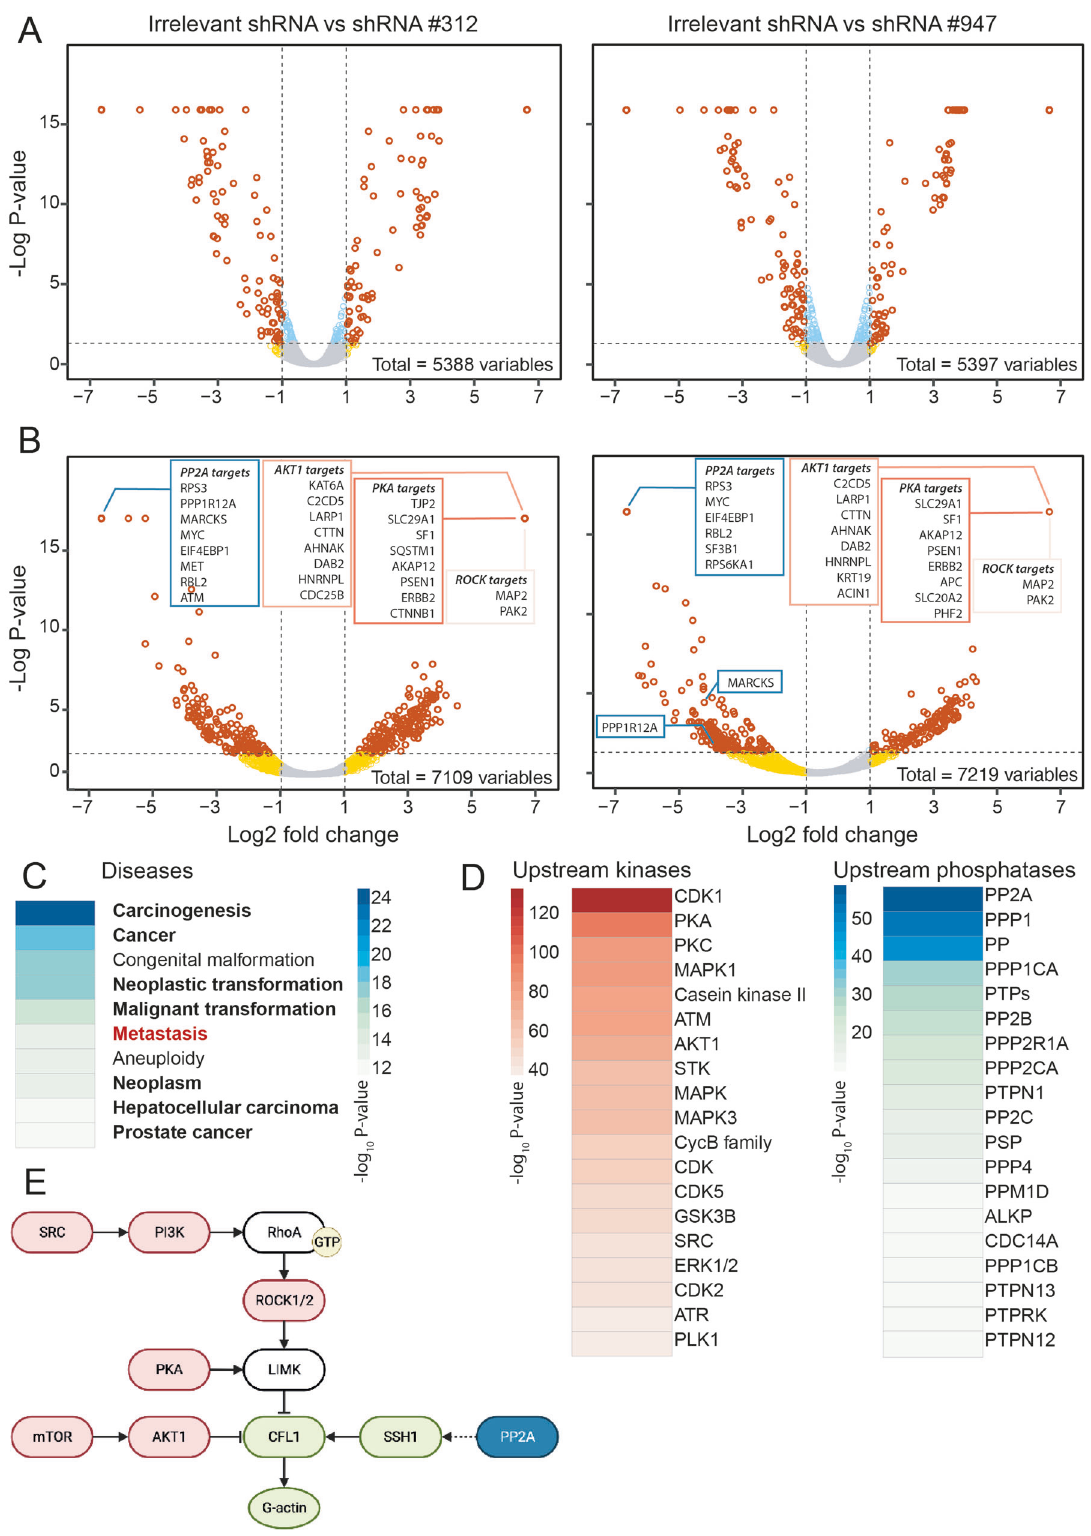
Fig. 4 Quantitative (phospho-)proteomics reveals paladin involvement in diseases and kinase/phosphatase activities. A Volcano plots displaying relative variation of protein abundance in HCT116 paladin shRNA clones. B Volcano plots displaying a relative variation of phospho- protein abundance in HCT116 paladin shRNA clones. C Heatmaps representing diseases highlighted by gene enrichment analysis. Results are presented as – log 10 P value. D Heatmaps representing top 20 kinases (out of 413) or phosphatases (out of 55) obtained from literature mining and able to catalyse phospho modi fi cations induced by paladin depletion. Results are presented as – log 10 P value. E Potential pathway altered by paladin depletion. Kinases and phosphatases able to catalyse phospho modi fi cations induced by paladin depletion are depicted in red and blue, respectively. Inferred proteins, considered the core pathway to further analyse, are depicted in